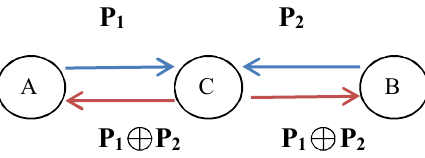
Fig. 1. An example of network coding